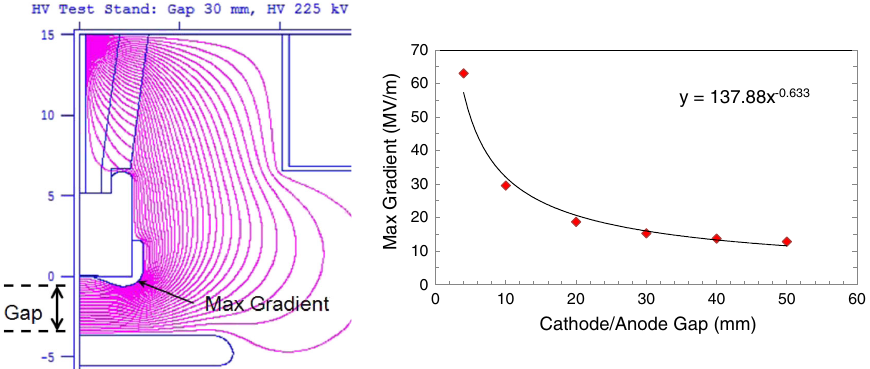
FIG. 2. (left) POISSON electrostatic field map showing lines of constant potential inside the field emission test apparatus. (right) Maximum field strength as a function of anode/cathode gap for 225 kV cathode bias voltage. Data points are from POISSON and the line is a simple fit using a power